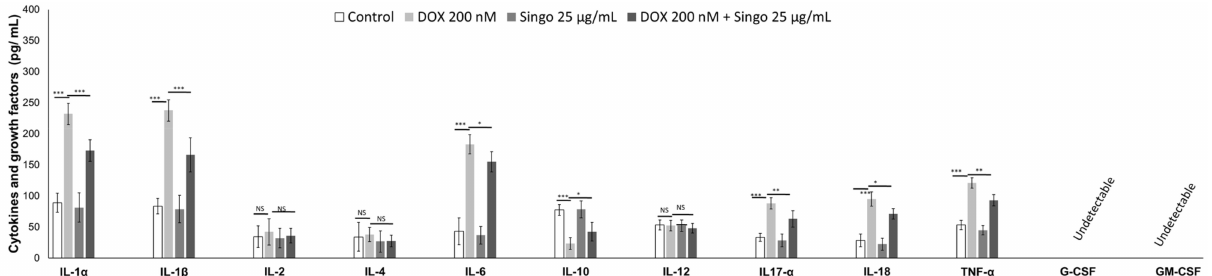
Figure 13. Cytokines and growth factors (IL-1 α , IL-1 β , IL-2, IL-4, IL-6, IL-10, IL-12, IL-17 α , IL-18, IFN- γ , TNF- α , G-CSF and GM-CSF) involved in cardiotoxicity and inflammation expressed as pg/mL were quantified in human cardiac cells unexposed (control) or exposed to DOXO (200 nM) or Singo (25 µ g/mL) or both in combination for 24 h. Results: mean +/ − SD. ns: not significant. *** p < 0.001. ** p < 0.01. * p <